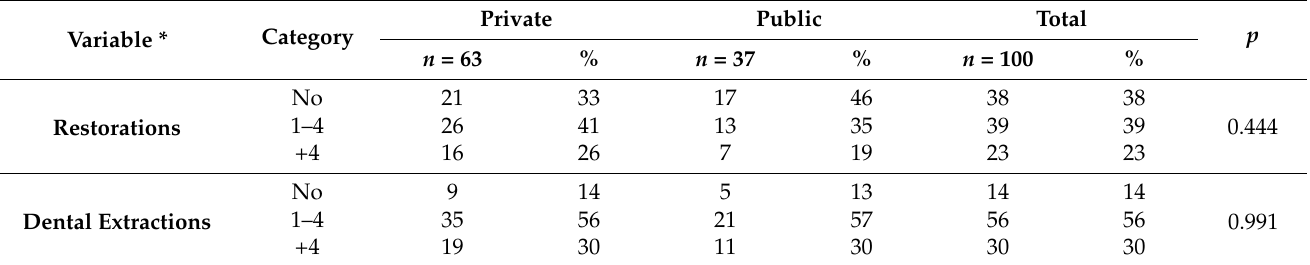
Table 7. The prevalence of most common procedures performed under GA by public and pri- vate providers.